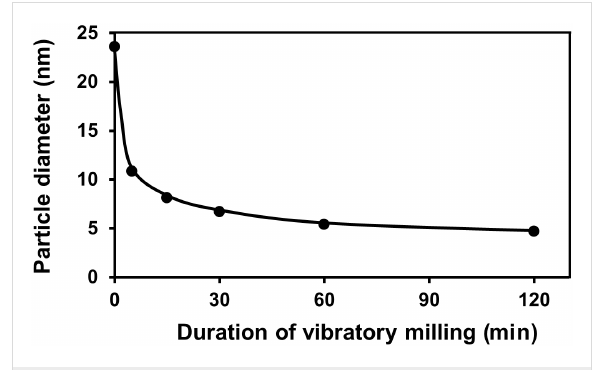
Figure 10: Change in Gly particle diameter during vibratory